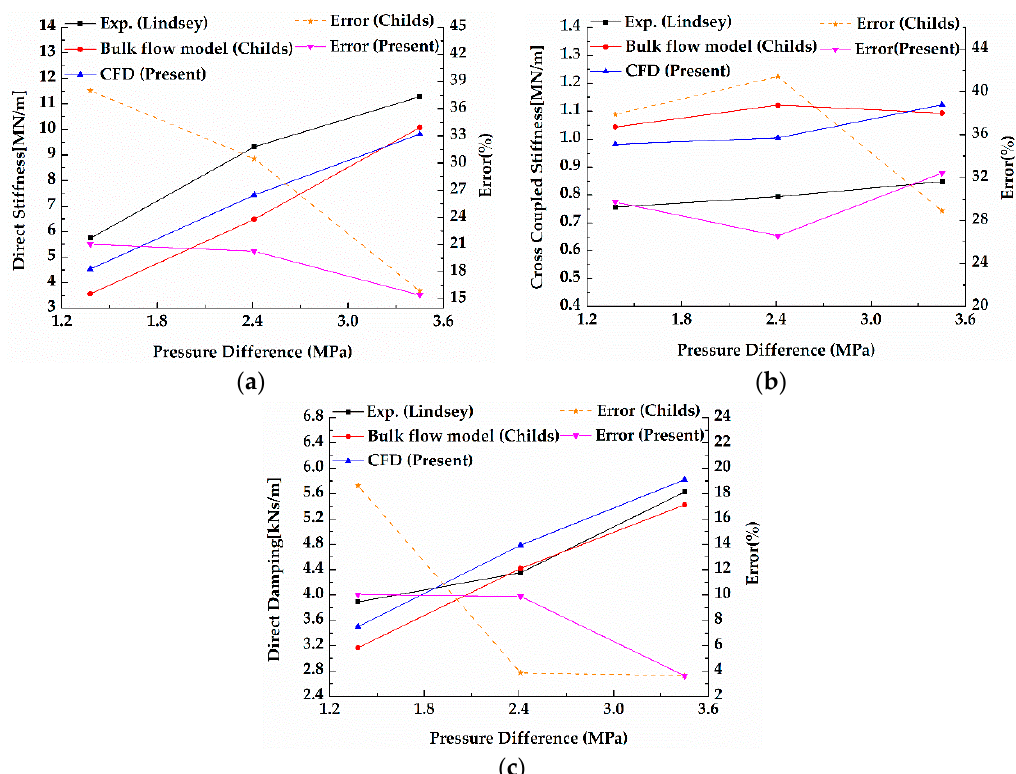
Figure 8. Rotordynamics coefficients as a function of pressure difference: ( a ) direct stiffness, ( b ) cross coupled stiffness, ( c ) direct damping.